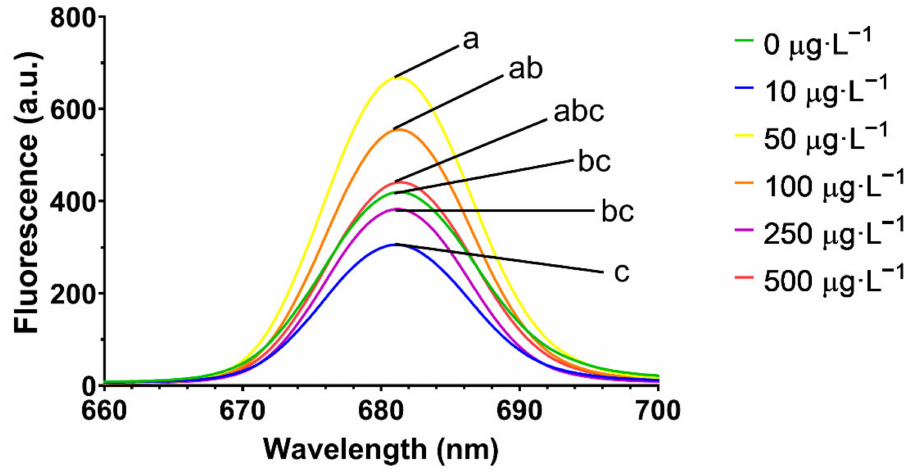
Figure 5. Red region laser-induced fluorescence in Ulva lactuca following a 48-h exposure to a glyphosate-based herbicide formulation in different concentrations (mean, n = 30, different letters indicate significant differences between treatments at p < 0.05).